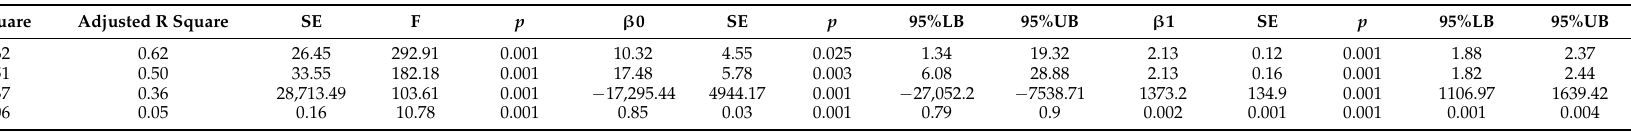
Table 6. Model summary, ANOVA report and coefficients for simple linear regression analysis—CV of RT versus Poincar é plot descriptors ( n = 180).